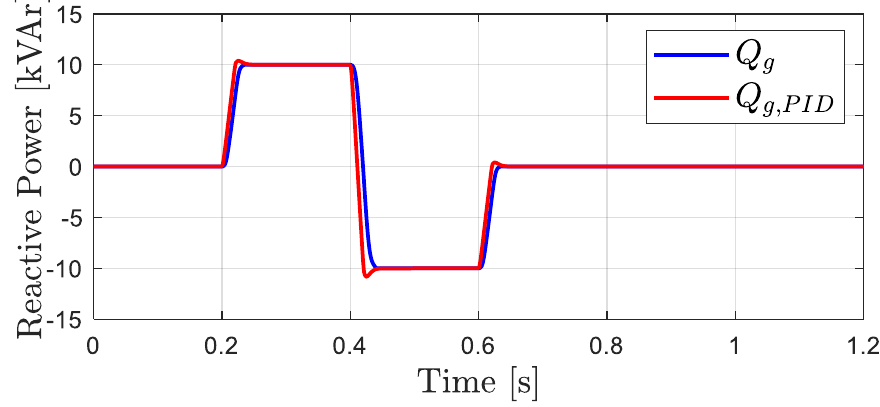
Figure 19. Reactive power to the grid time profile comparison.